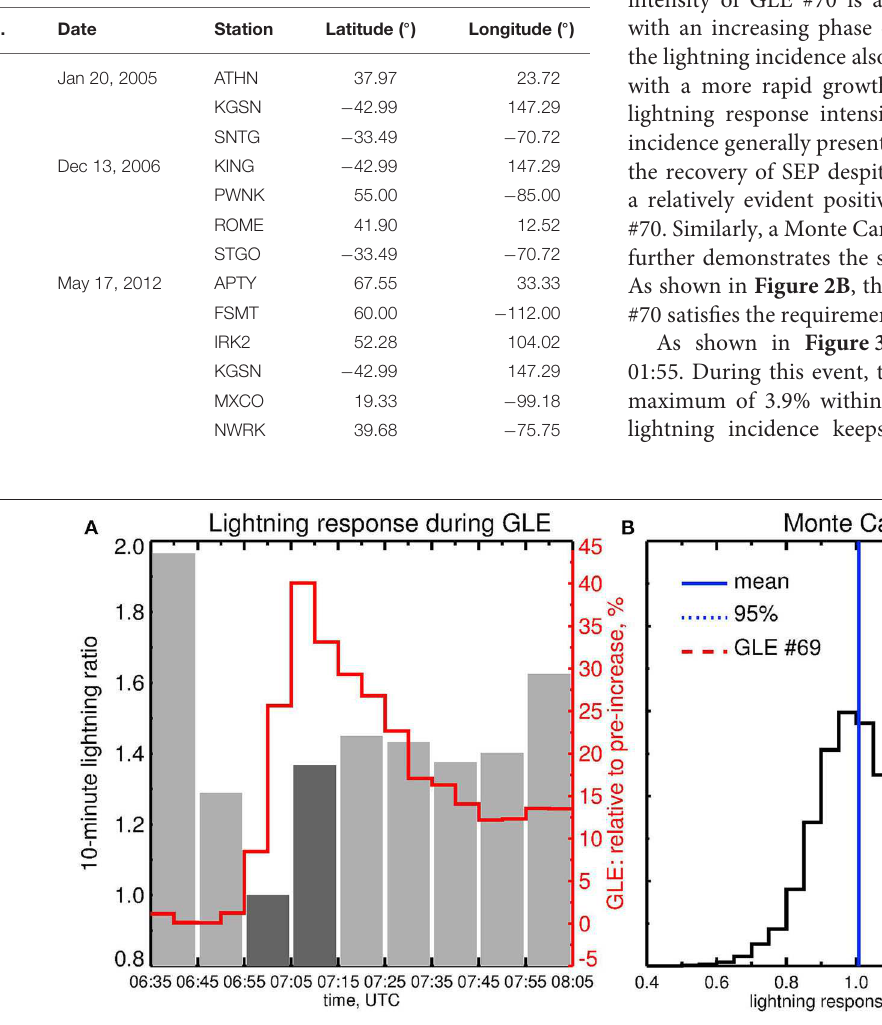
FIGURE 1 | (A) Lightning response during GLE #69 (Jan 20, 2005). The red line represents the relative change of 5-min neutron counting rates, the gray bars represent the relative variation of 10-min lightning incidence. (B) Results of the Monte Carlo test in 2005. The total number of tests is 9,000. The blue solid line represents the mean value, the blue dotted line represents the value at 95% confidence level, and the red dashed line represents the observed lightning response intensity.